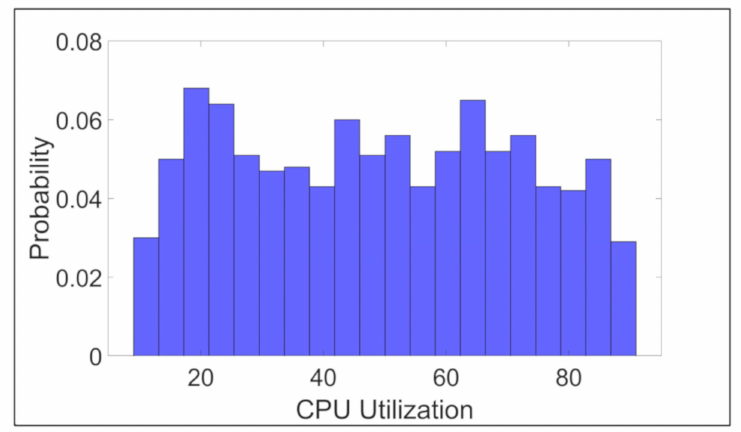
Figure 6. Probability distribution of the generated requests’ CPU-utilization values.